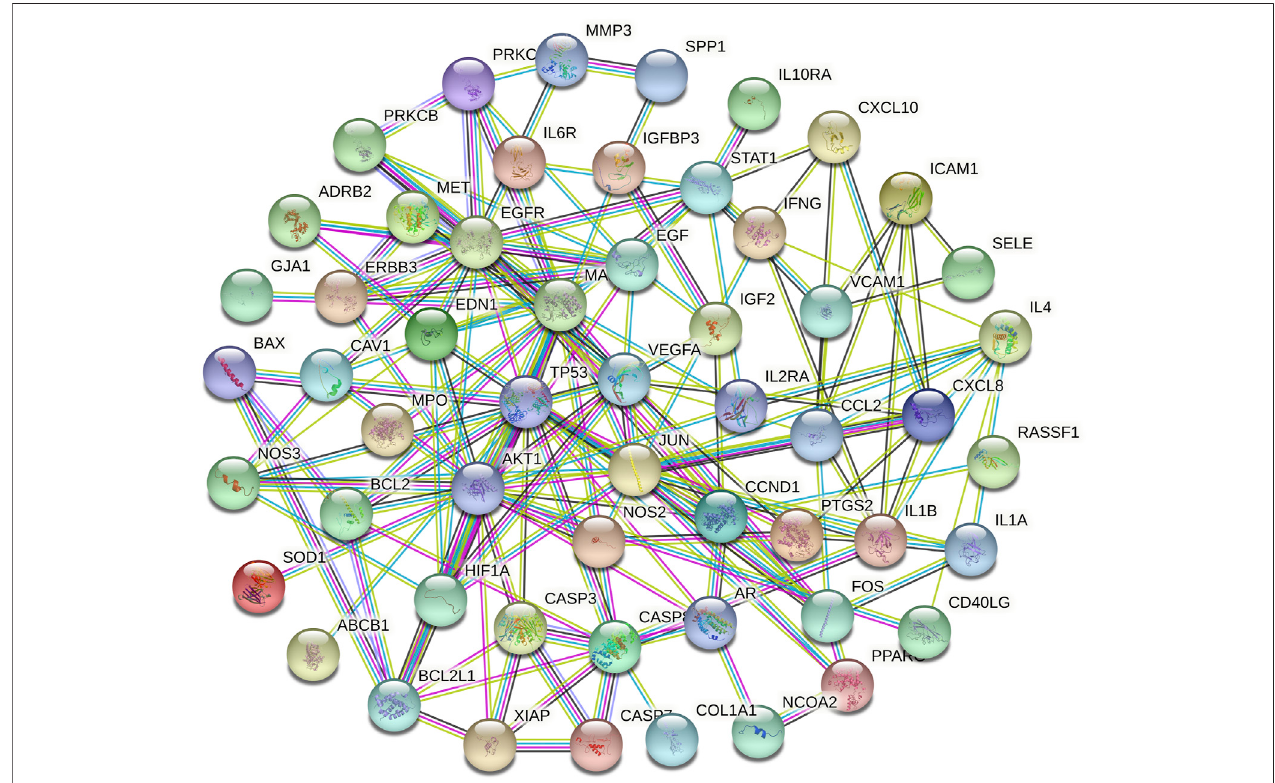
FIGURE 4 | The PPI networks of relative